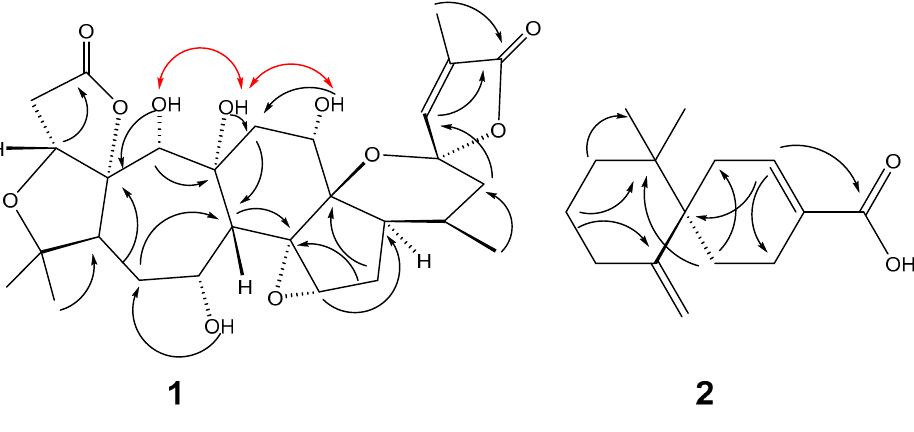
Figure 2. Key HMBC ( ) and NOE ( ) correlations of compounds 1 and 2 .